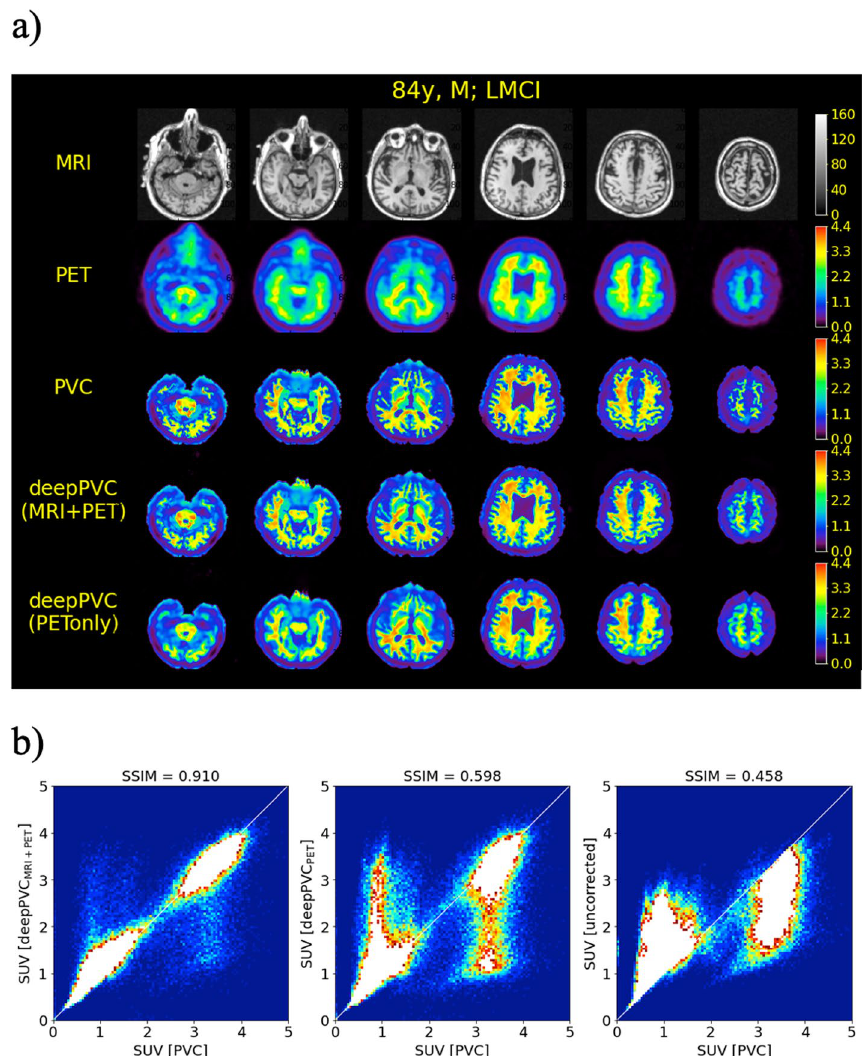
Fig. 3 MR images, SUV maps a , and 2D histograms of the PV-corrected map ( b ) for the representative PiB-negative case (84 years old; male; MCI). The 2D histograms, left to right, represent maps predicted with deepPVC MRI , deepPVC PET , and uncorrected PET, respectively. The white lines on the histograms indicate + PET perfect correspondence with the real PV-corrected SUV. MCI, mild cognitive impairment; MR, magnetic resonance; MRI, MR imaging; PET, positron emission tomography; PVC, partial volume correction; SUV, standardized uptake